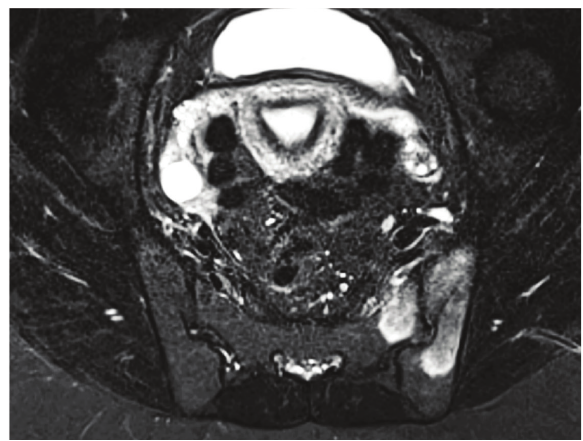
Figure 4: MRI demonstrating extensive subchondral bone marrow hyperintensities on axial STIR sequence involving both iliac and sacral bones on the left side, consistent with bone marrow edema.